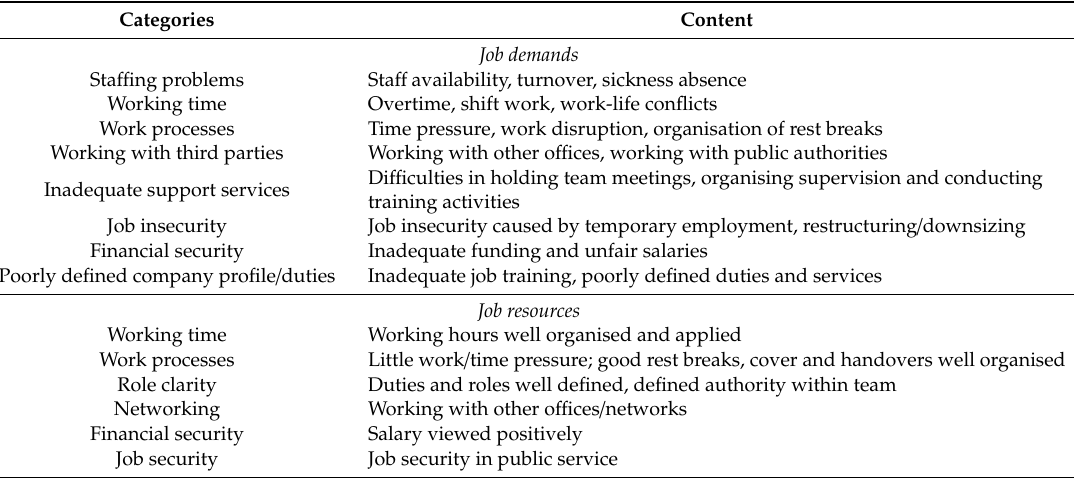
Table 3. Job demands and resources relating to work